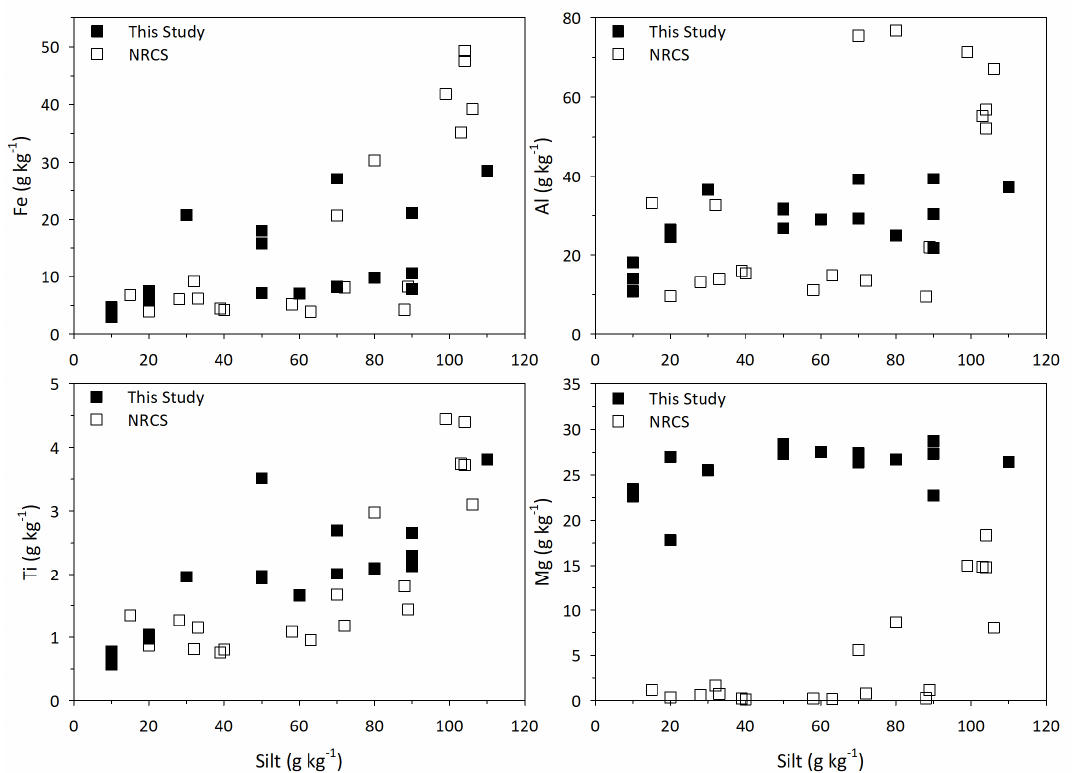
Figure 9. Iron, Al, Ti, and Mg against silt content for the NCSS database and using the pXRF data from this study.